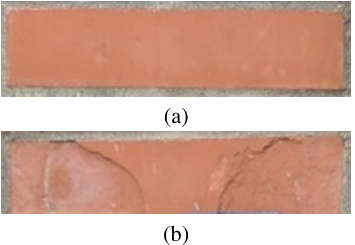
Figure 5. Example of brick in good conditions (a) and a damaged one (b).